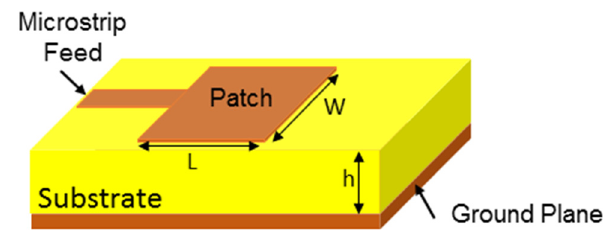
Figure 16. Basic design of the microstrip Antenna.